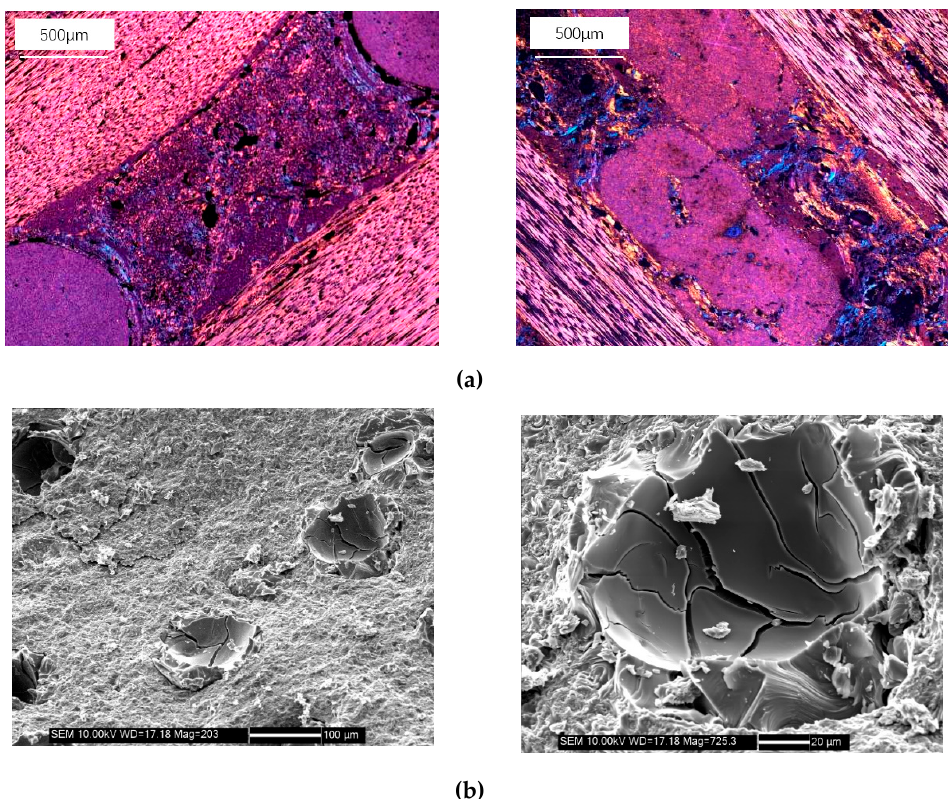
Figure 7. Surface microstructure characteristics of the matrix phase of axially braided C/C composite. (a) Micrograph of the carbon matrix phase by SEM and (b) morphology of carbon matrix pores by SEM.